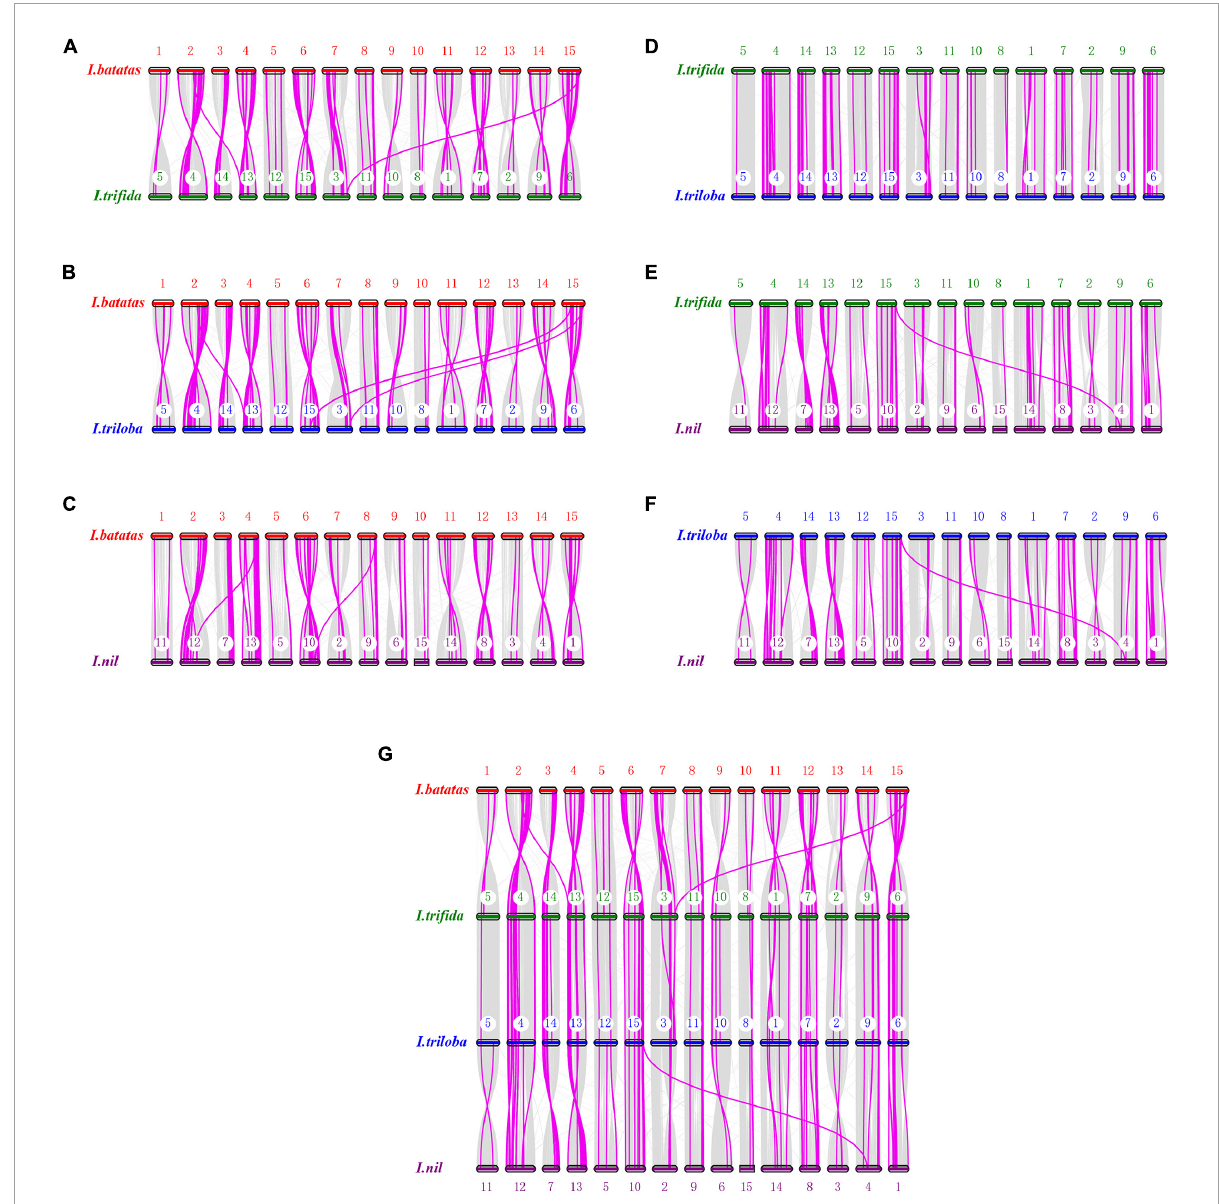
FIGURE5 Synteny analysis of nucleotide-binding site (NBS)-encoding genes. (A) Synteny between sweet potato and I. trifida . (B) Synteny between sweet potato and I. triloba . (C) Synteny between sweet potato and I. nil . (D) Synteny between I. trifida and I.triloba . (E) Synteny between I. trifida and I. nil. (F) Synteny between I.triloba and I.nil . (G) Schematic representation of syntenic genes among sweet potato, I. trifida , I. triloba , and I. nil . The chromosomes of sweet potato, I. trifida , I. triloba , and I. nil were assigned with red, green, blue, and purple, respectively. Gray lines connect matched gene pairs, with NBS-encoding gene pairs highlighted in